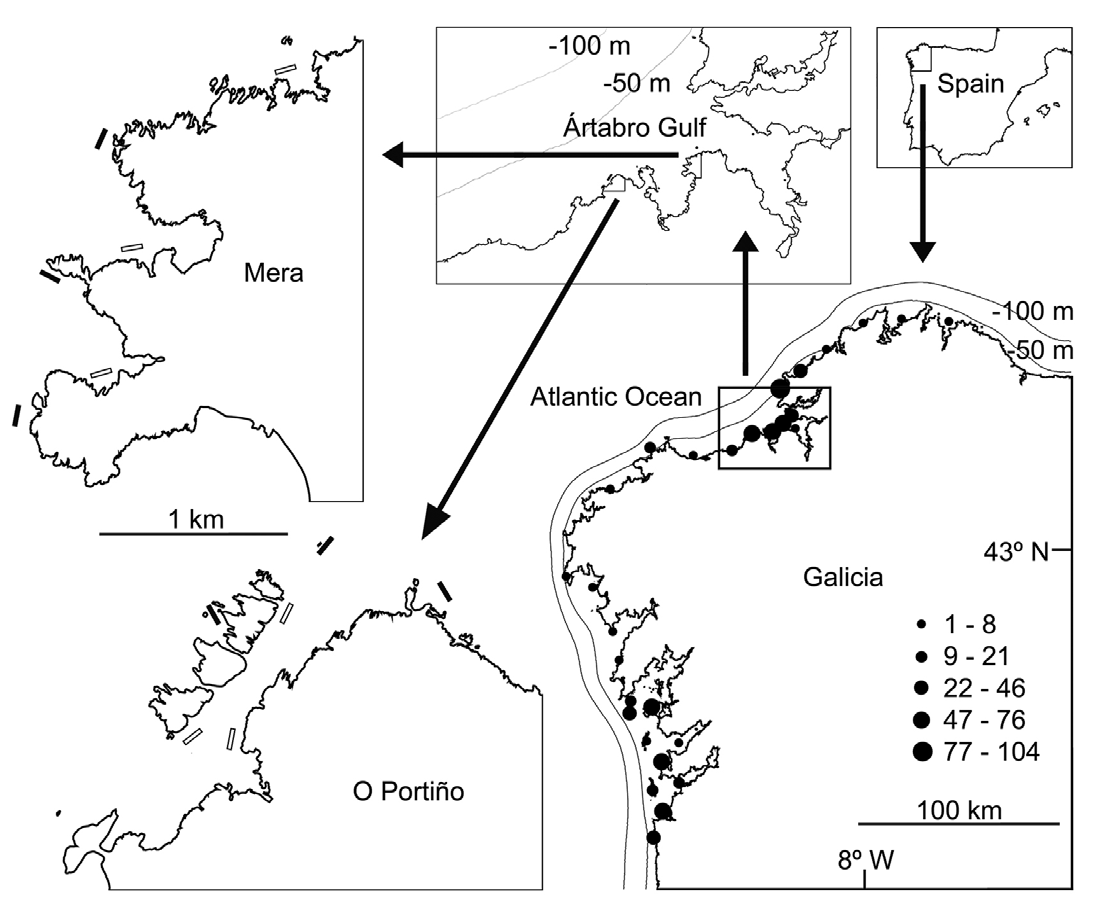
Fig. 1. – Map of the study area indicating the number of spear fishing competitions held in each area (the size of the point indicates the number of competitions). The locations of the rocky reefs in the Artabro Gulf (O Portiño and Mera) in which the UVCs were carried out are shown. The lines indicate the locations of the transects (100 m). The transects in areas exposed to waves are drawn in black and the transects in protected areas are drawn in